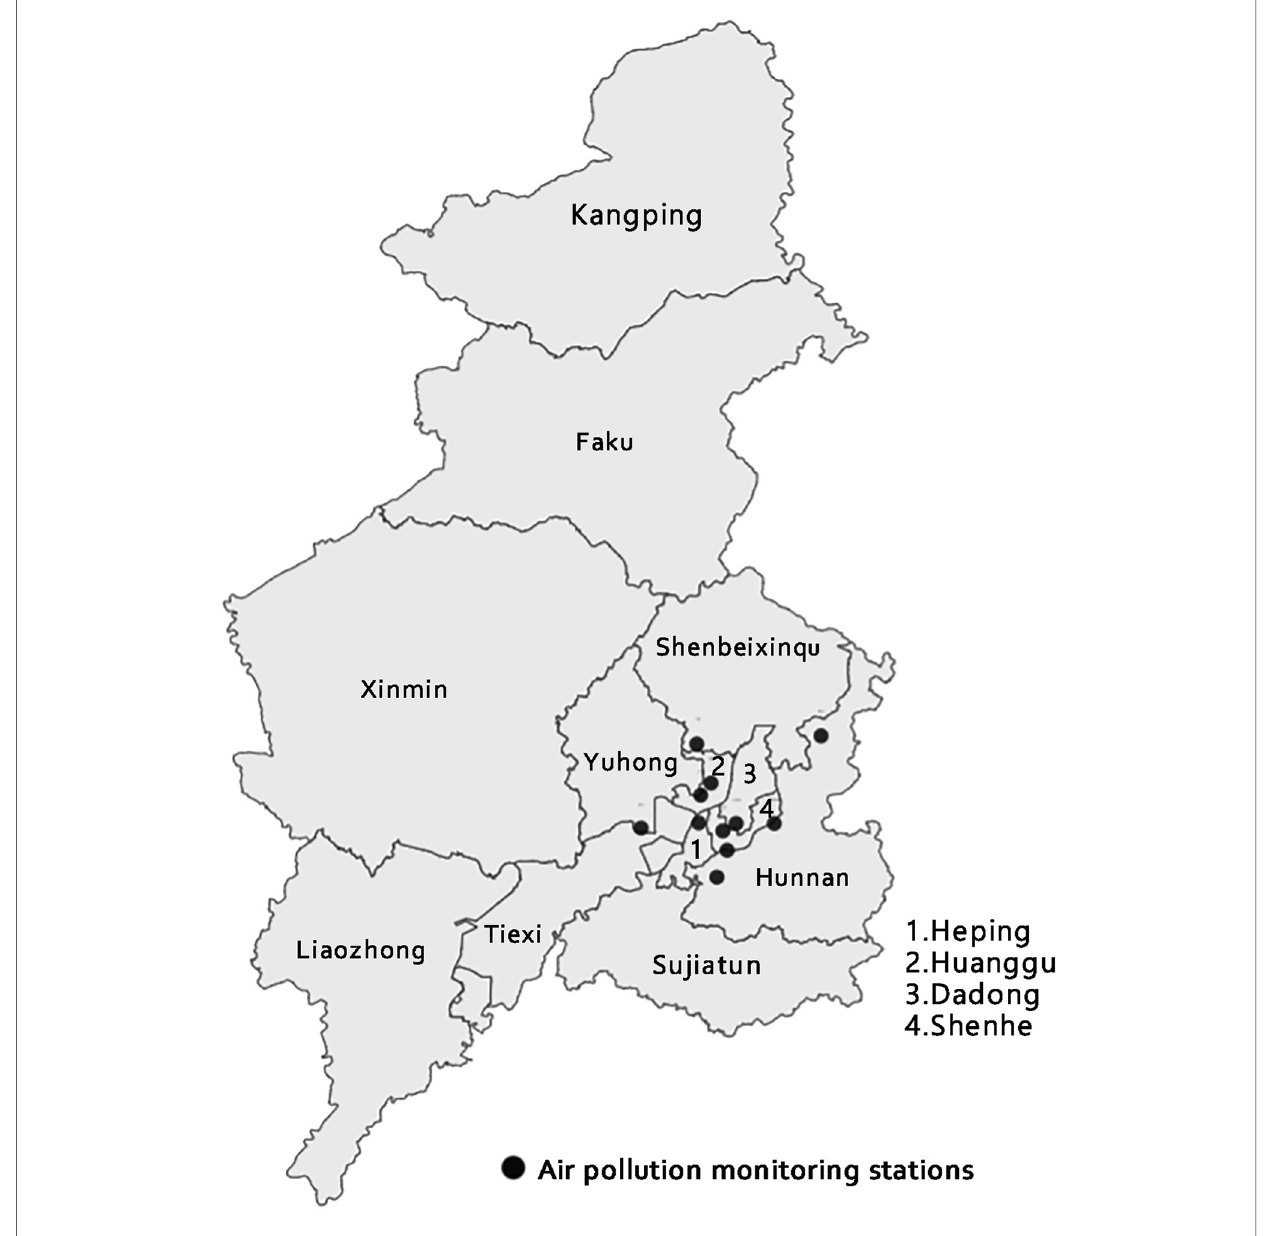
FIGURE 1 Distribution of air quality monitoring stations in